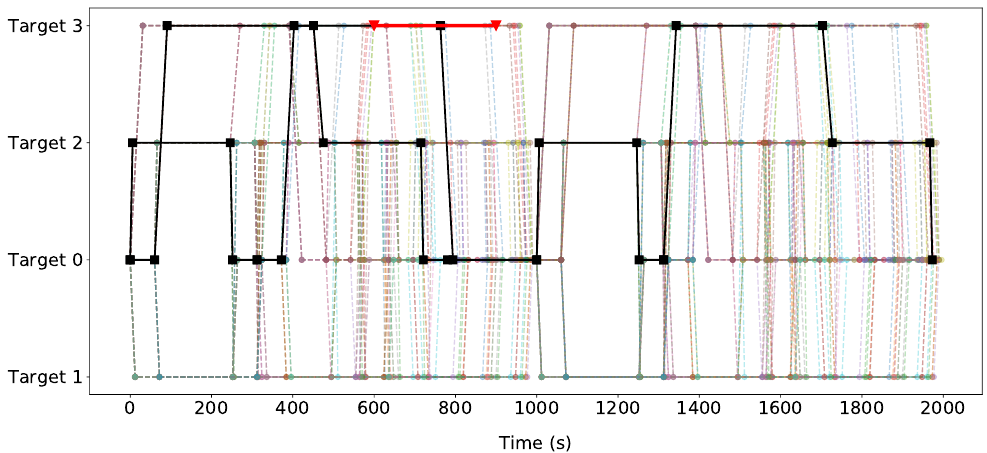
Figure 6. The optimal patrolling strategy over time and the attacker’s best response. The black lines symbolize the defender’s optimal (probabilistic) patrolling strategy. Each line segment (each movement) has an associated number representing the probability that the defender will do that movement. The red line illustrates the attacker’s best response strategy. Please note that the red line only covers T 3 for the sake of visualization simplicity. In reality, the attacker enters the airport through its entrance ( T 0 ) and takes some time to arrive at the target destination. Lastly, the remaining colors with lower opacity represent all possible movements that may have been chosen by the security